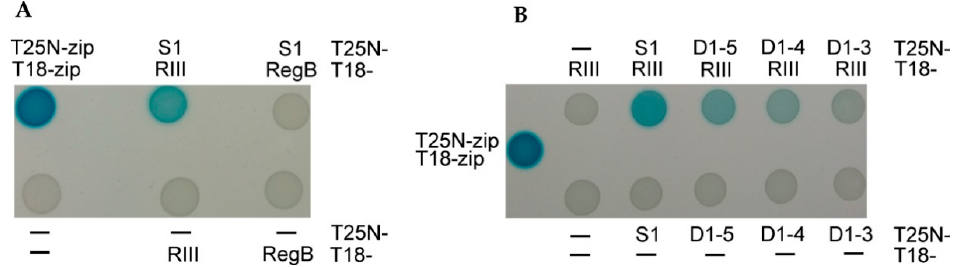
proteins RegB and RIII using the BACTH system [52]. ( A ) Interactions between the intact proteins S1 and RIII, and S1 and RegB. ( B ) Interactions of RIII protein with the intact protein S1 or its truncated variants. Positive control—T18 and T25 fragments fused with leucine zippers; negative control—T18 and T25 adenylate cyclase fragments without fusions (marked by – ); T25N and T18 fusions with different proteins are specified next to the spot results. Blue color of the spots indicates adenylate cyclase activity due to the interaction between proteins fused to the T18 and T25 fragments.